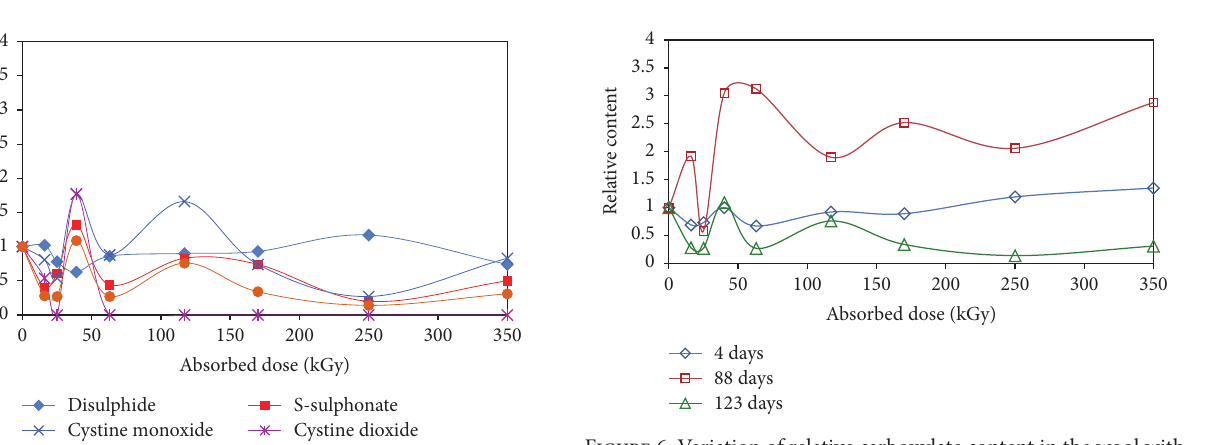
Figure 6: Variation of relative carboxylate content in the wool with absorbed dose; time data mean lapse from the